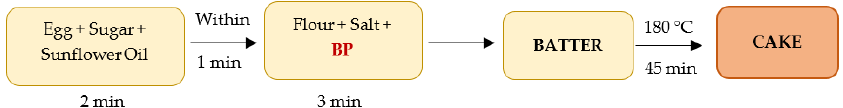
Figure 1. Batter and pound cake making